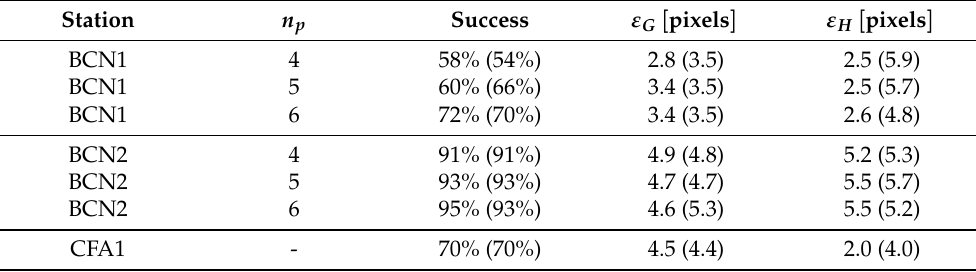
Table 4. Percentage of success and 95th percentile of errors ε G and ε H for the successful control images for different stations and n p (for f (cid:54) f C = 5pixels and K (cid:62) K C = 4). In parentheses, values when the horizon error was not considered in the manual calibration of the basis.